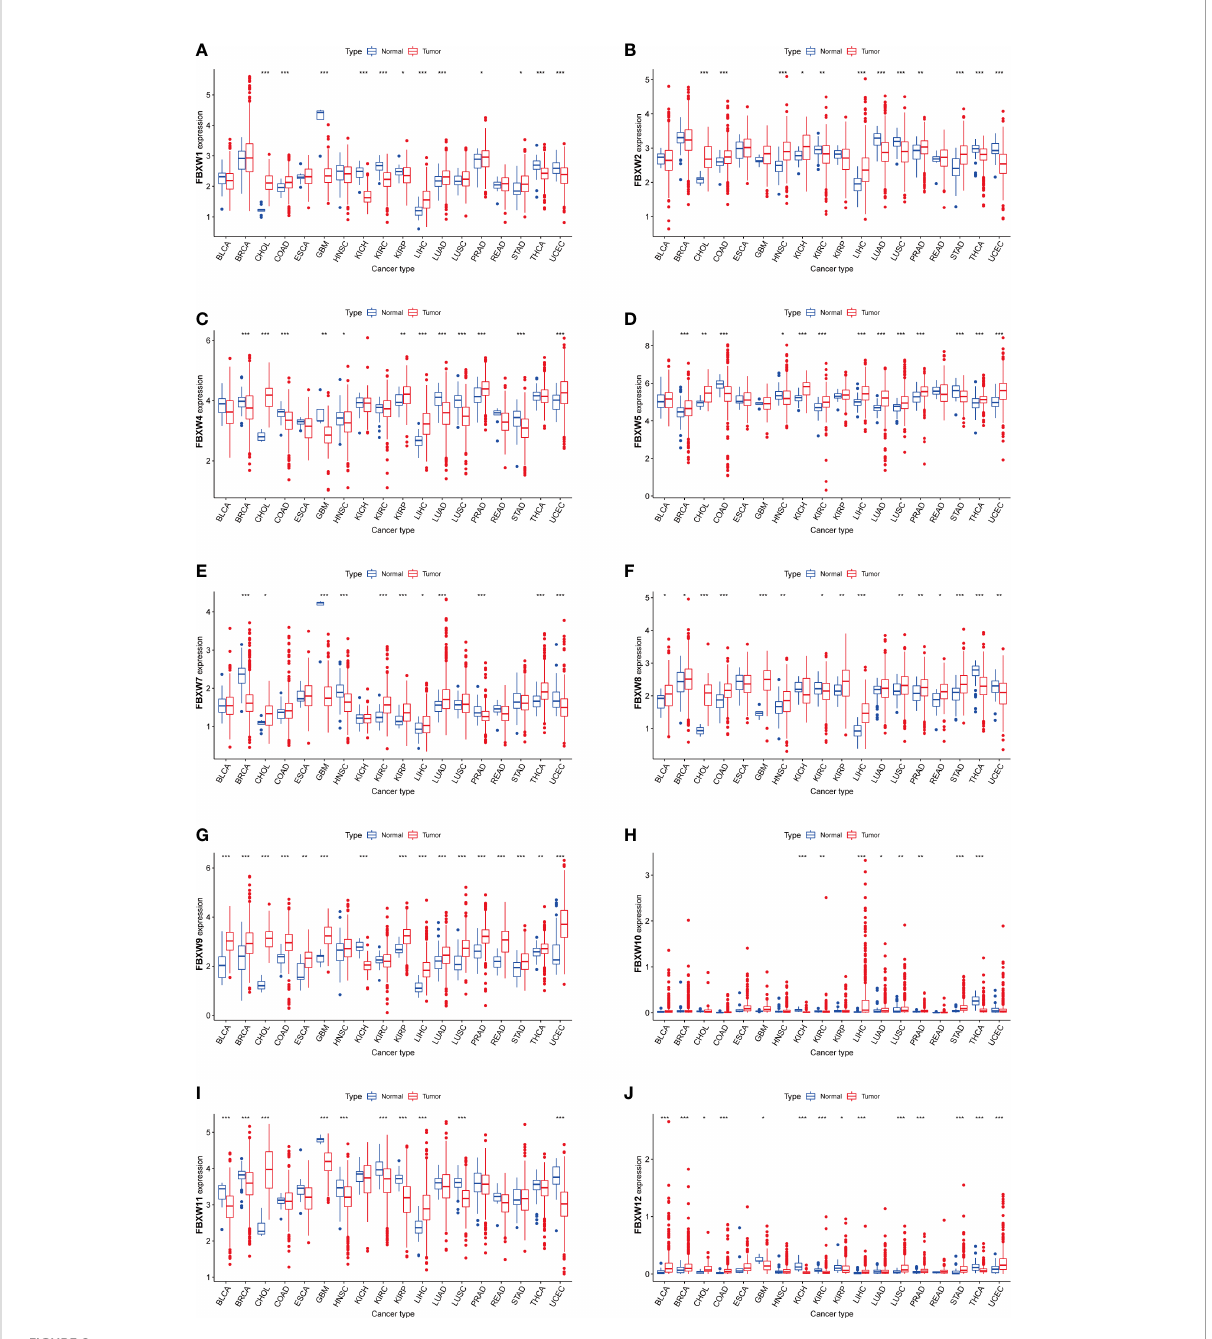
FIGURE 2 Boxplot of FBXW family (A – J) differential expression between cancer and adjacent normal tissues. The blue boxplots indicate the normal tissues. The red boxplots indicate the cancer tissues. ∗ P< 0.05, ∗∗ P< 0.01, and ∗∗∗ P<